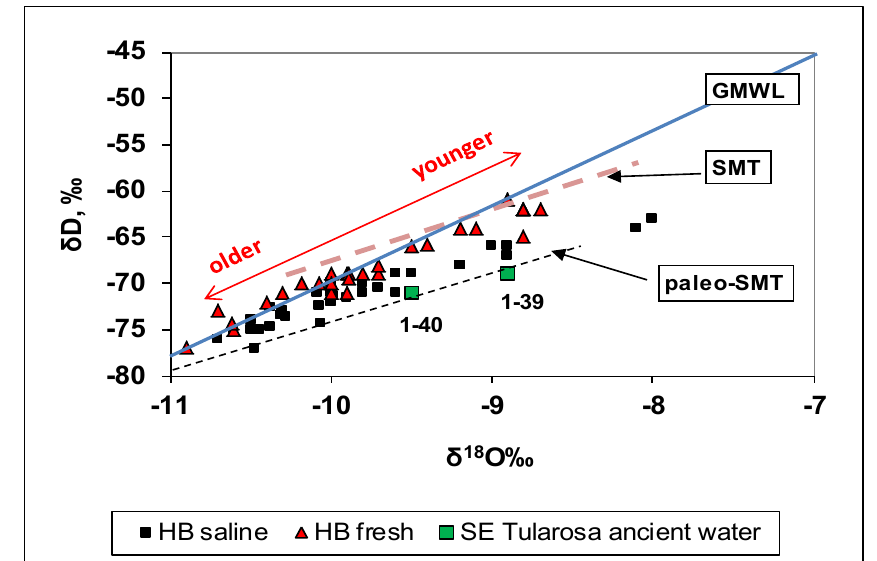
Figure 9. Plot of δ 18 O vs . δD showing: ( a ) The Sacramento Mountains Trend (SMT, as in Figure 4) and data for groundwater at Alamogordo; ( b ) Data for groundwater in the Hueco Bolson in Texas, from [2] and [24], distinguished according to salinity (HB-saline at the basin center, and HB-fresh from the Franklin Mountains fresh water lens on the western